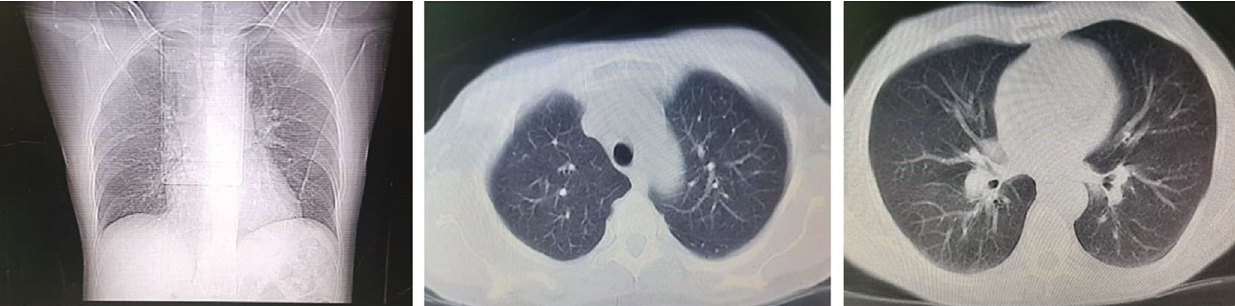
Figure 1: (a) First sonographic image. (b) Second sonographic